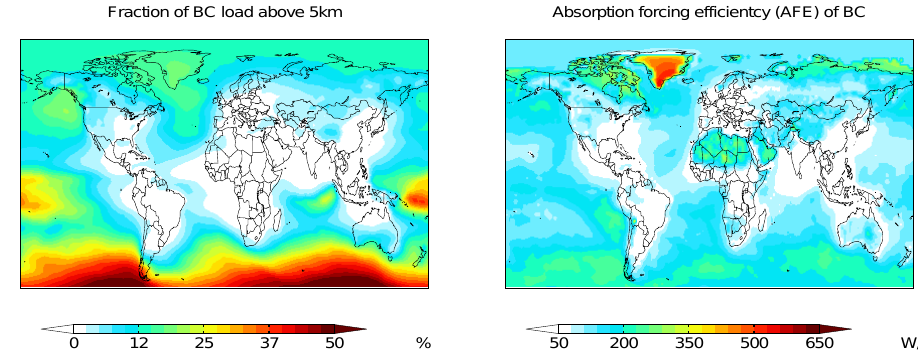
Figure 12. Global distribution of the fraction of BC mass load over 5km (left) and BC absorption forcing efficiency (right, AFE = DRE/AAOD at 550nm). Table 2. Global average of mass and optical related properties of BC in GC-RT (for year 2010) and other studies. Note that pre-industrial emissions in our study and AeroCom models are the same (Dentener et al.,